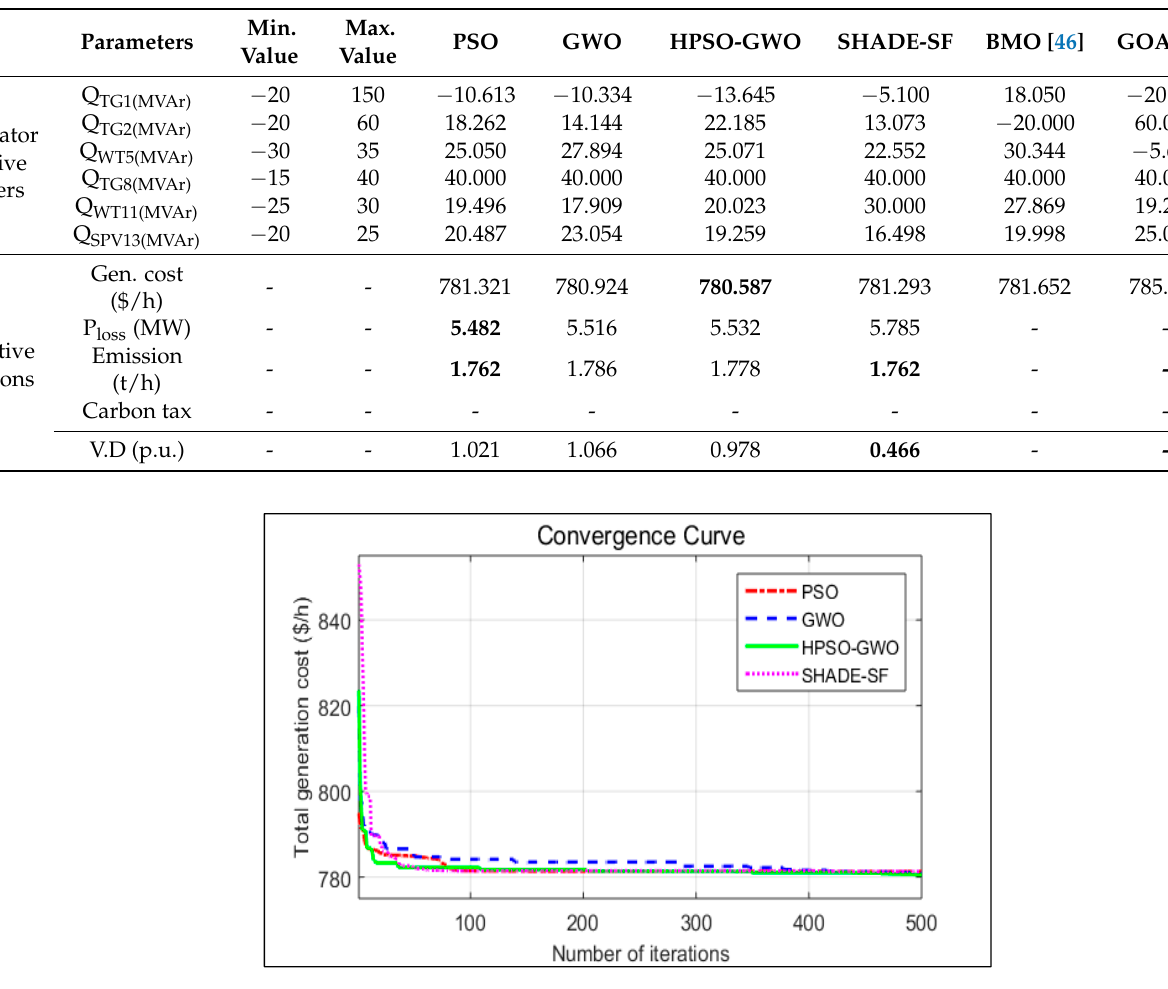
Figure 19. OPF convergence curves comparison (Case 4).